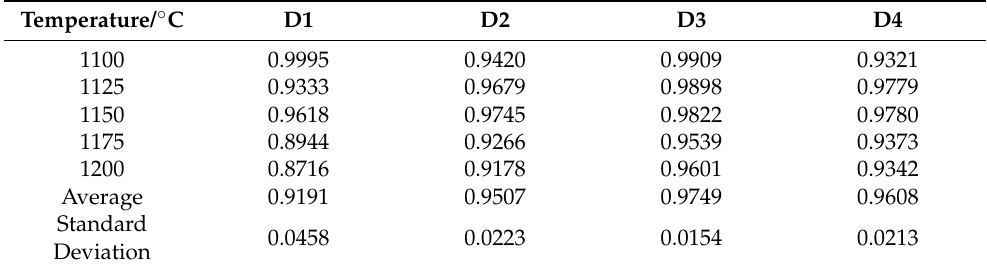
Table 5. Comparison of correlation coefficient ( R 2 ) fitted by different kinetic